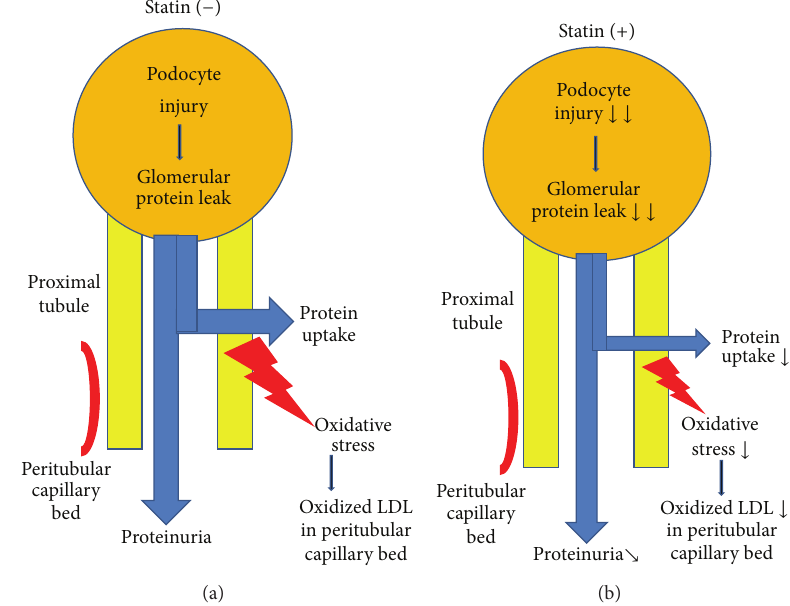
Figure 3: Multiple actions of statin on chronic kidney diseases: statin decreases proximal tubular uptake of protein leaked from glomeruli, reducing oxidative stress. Statin also improves podocyte injury, reducing glomerular protein leak. To obtain significant reductions in proteinuria by statin, the decrements in glomerular protein leak must be larger than those of proximal tubular uptake of protein by